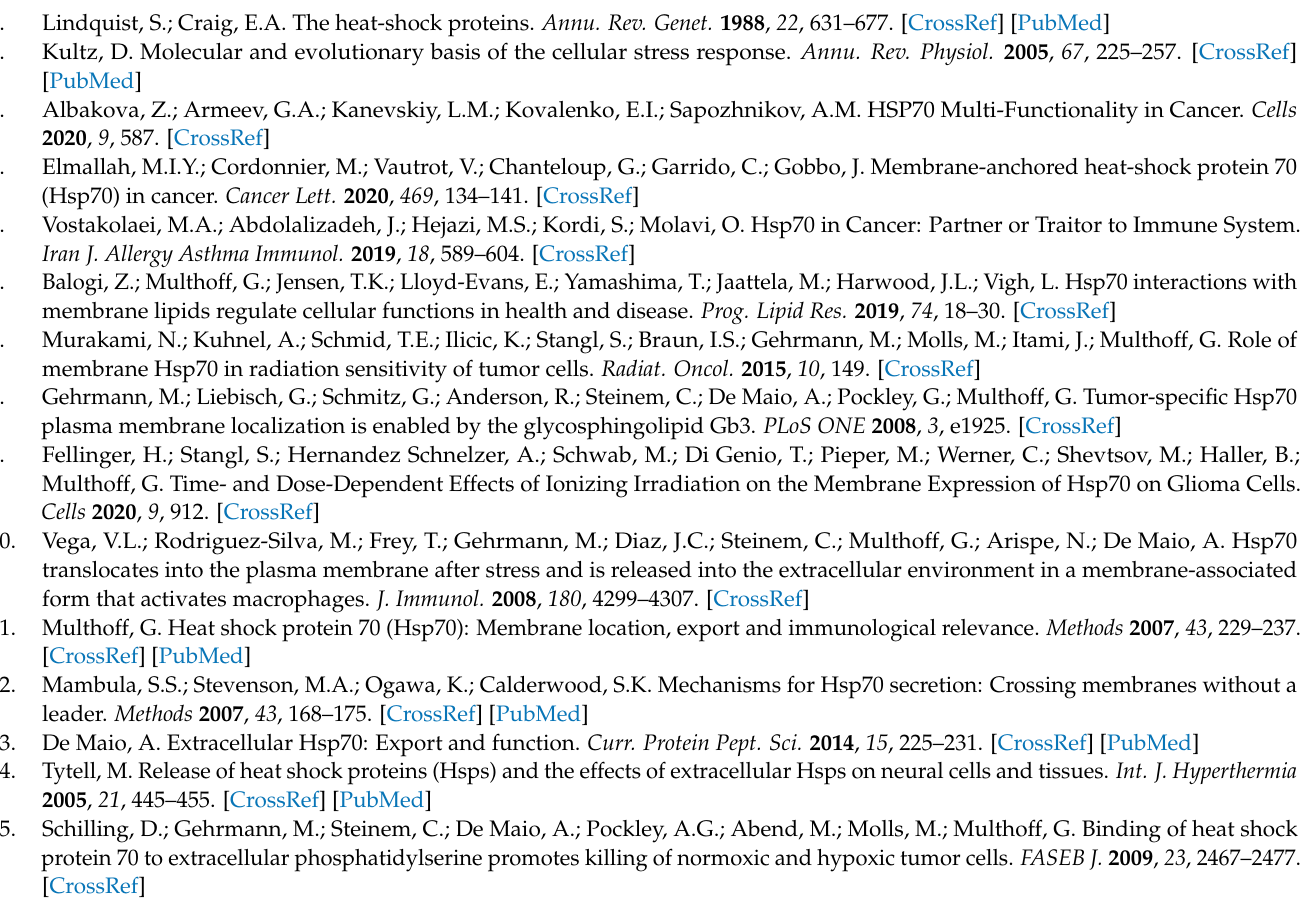
membranes (O), and plasma mem-brane (P) are shown, Figure S4. Cell surface biotinylation reveals that HSPA1A’s PM localization depends on the availability of PS, PI(4)P, and PI(3)P, but not PI(4,5)P2, Figure S5. Cell surface biotinylation reveals that HSPA1A’s PM is decreased after heat-shock in cells treated with Phenyl arsine oxide (PAO) and wortmannin (Wort), Figure S6. Effect of treatment with GSK-A1 on the PM localization of HSPA1A and several lipid biosensors, Figure S7. The subcellular distribution of EEA1, the biosensor for PI(3)P, is unaffected by the Sac1 and INPP5E